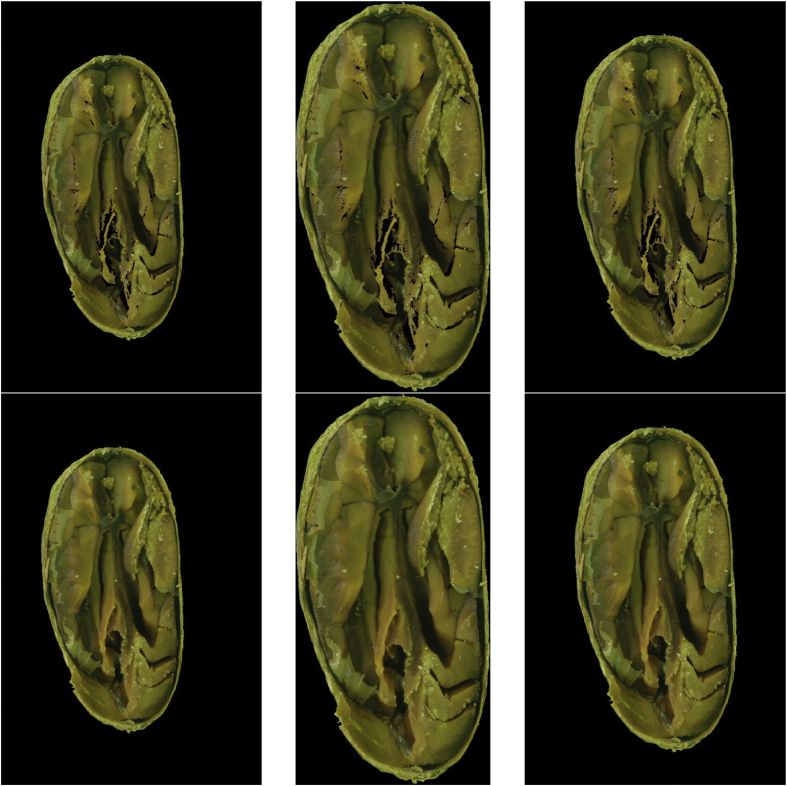
The six versions created from the bean from Fig. 1.